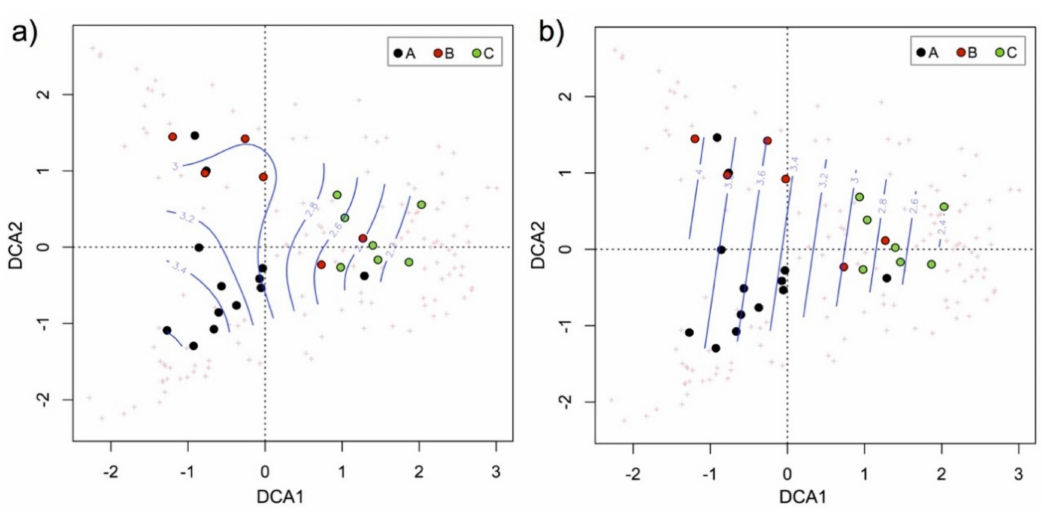
Table of relev é s performed in Taleggio Valley. Key: A, meadows; B, meadows-pastures; C, pastures; D, shrublands; E, forests. Cover indices refer to the Braun-Blanquet abundance / dominance scale. Table S3: Eigenvalues for the first four axes of DCAs.